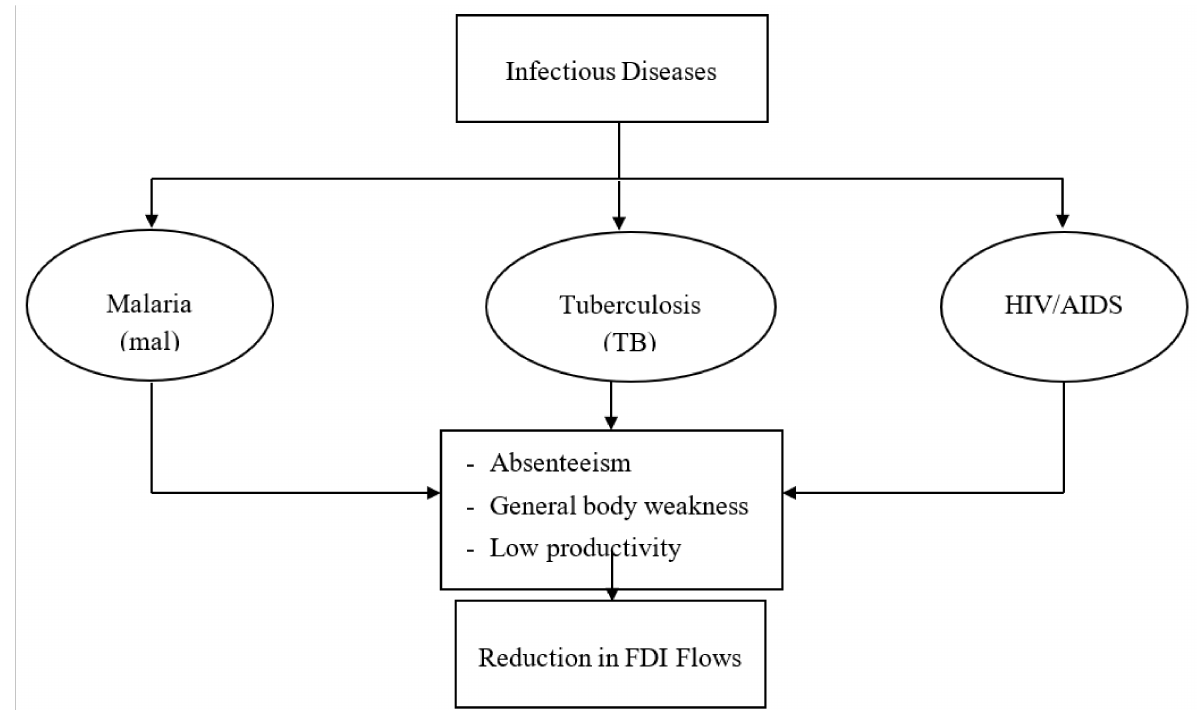
Figure 3. Conceptual linkages between infectious diseases and foreign direct investment